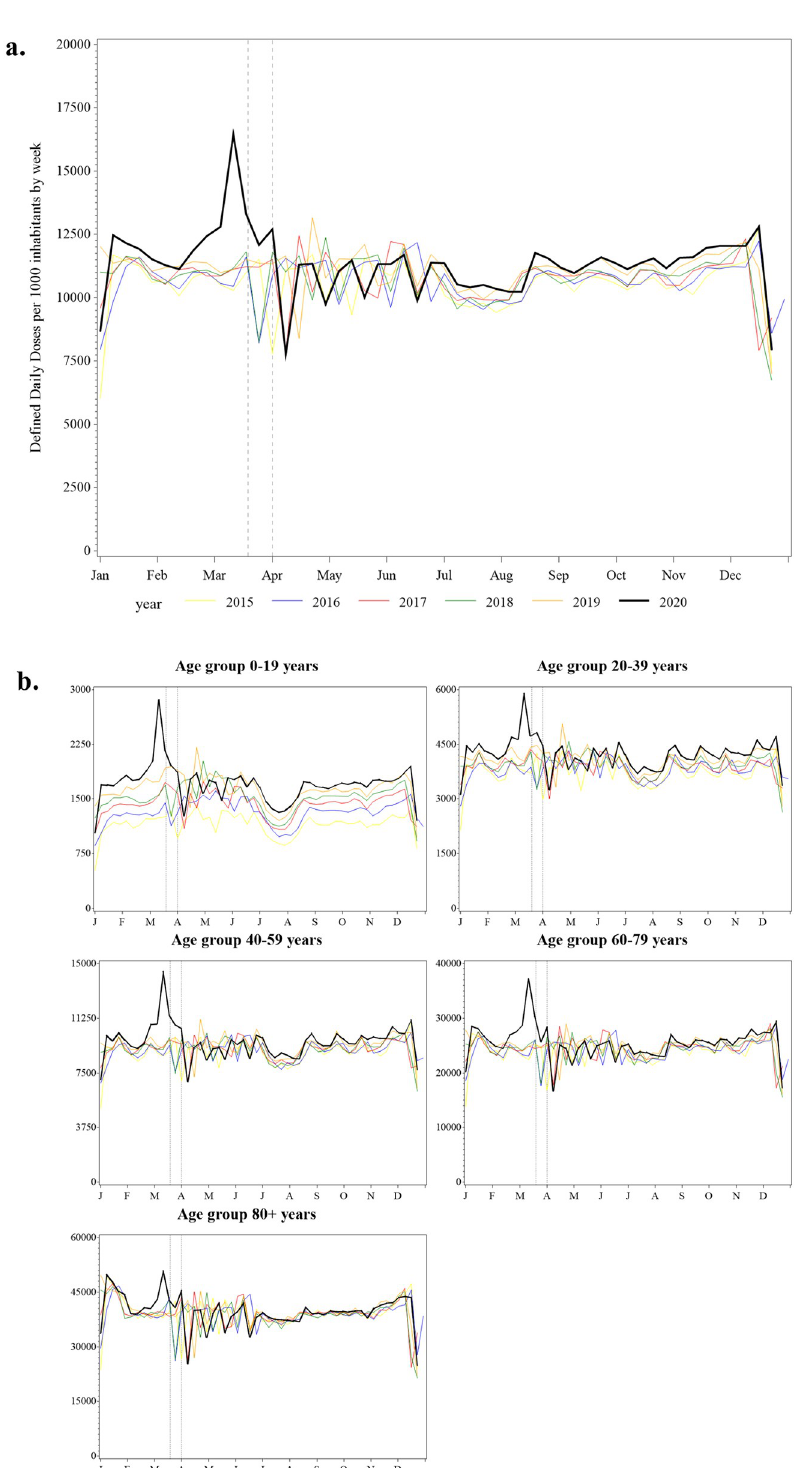
Fig 1. Volume of dispensed defined daily doses of prescription medication per 1000 inhabitants by week, 2015– 2020, Sweden (a) the entire population and (b) by age group. Note: The vertical lines indicate the weeks containing March 19 th and April 1 st 2020 when limits on medication sales were recommended and then mandated in Sweden, respectively.